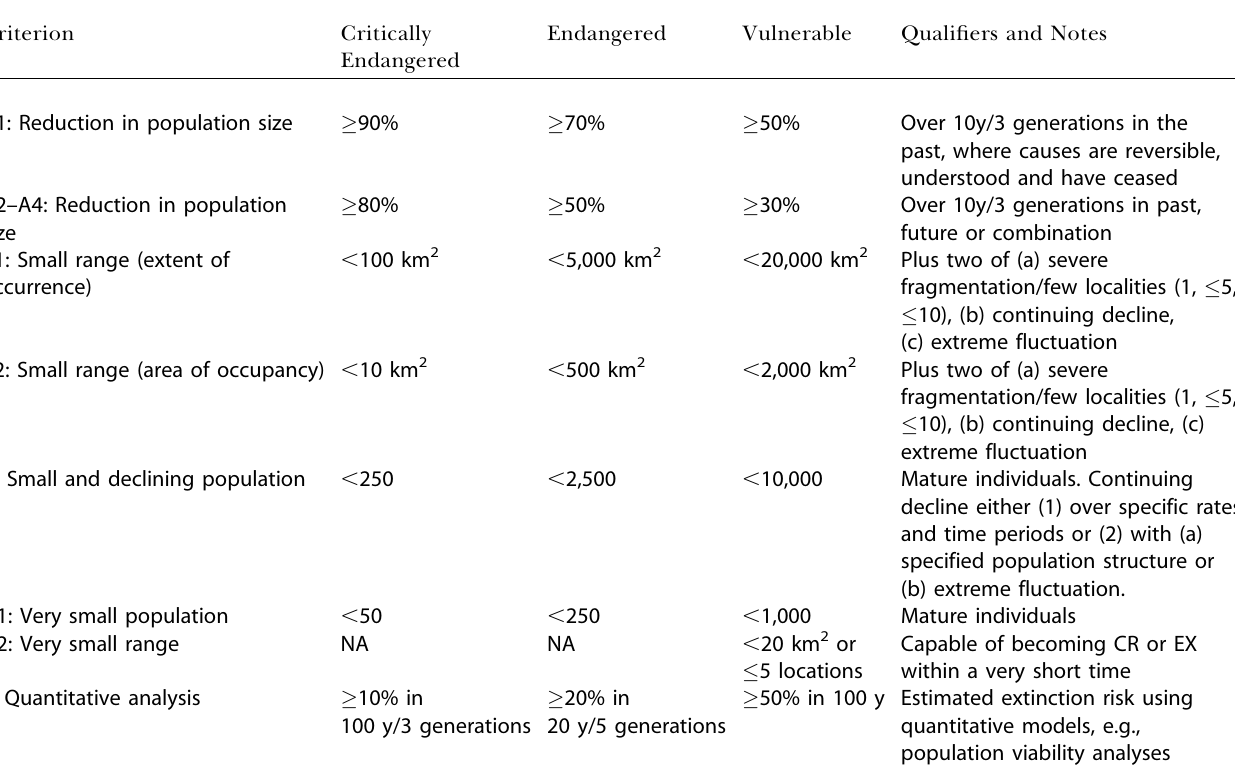
Table 1. Simplified Overview of Thresholds for the IUCN Red List Criteria